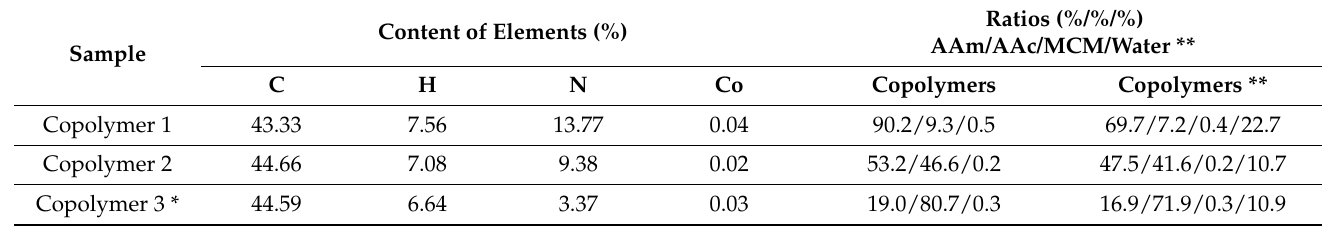
Table 2. Results of elemental analysis and composition of the obtained copolymers.